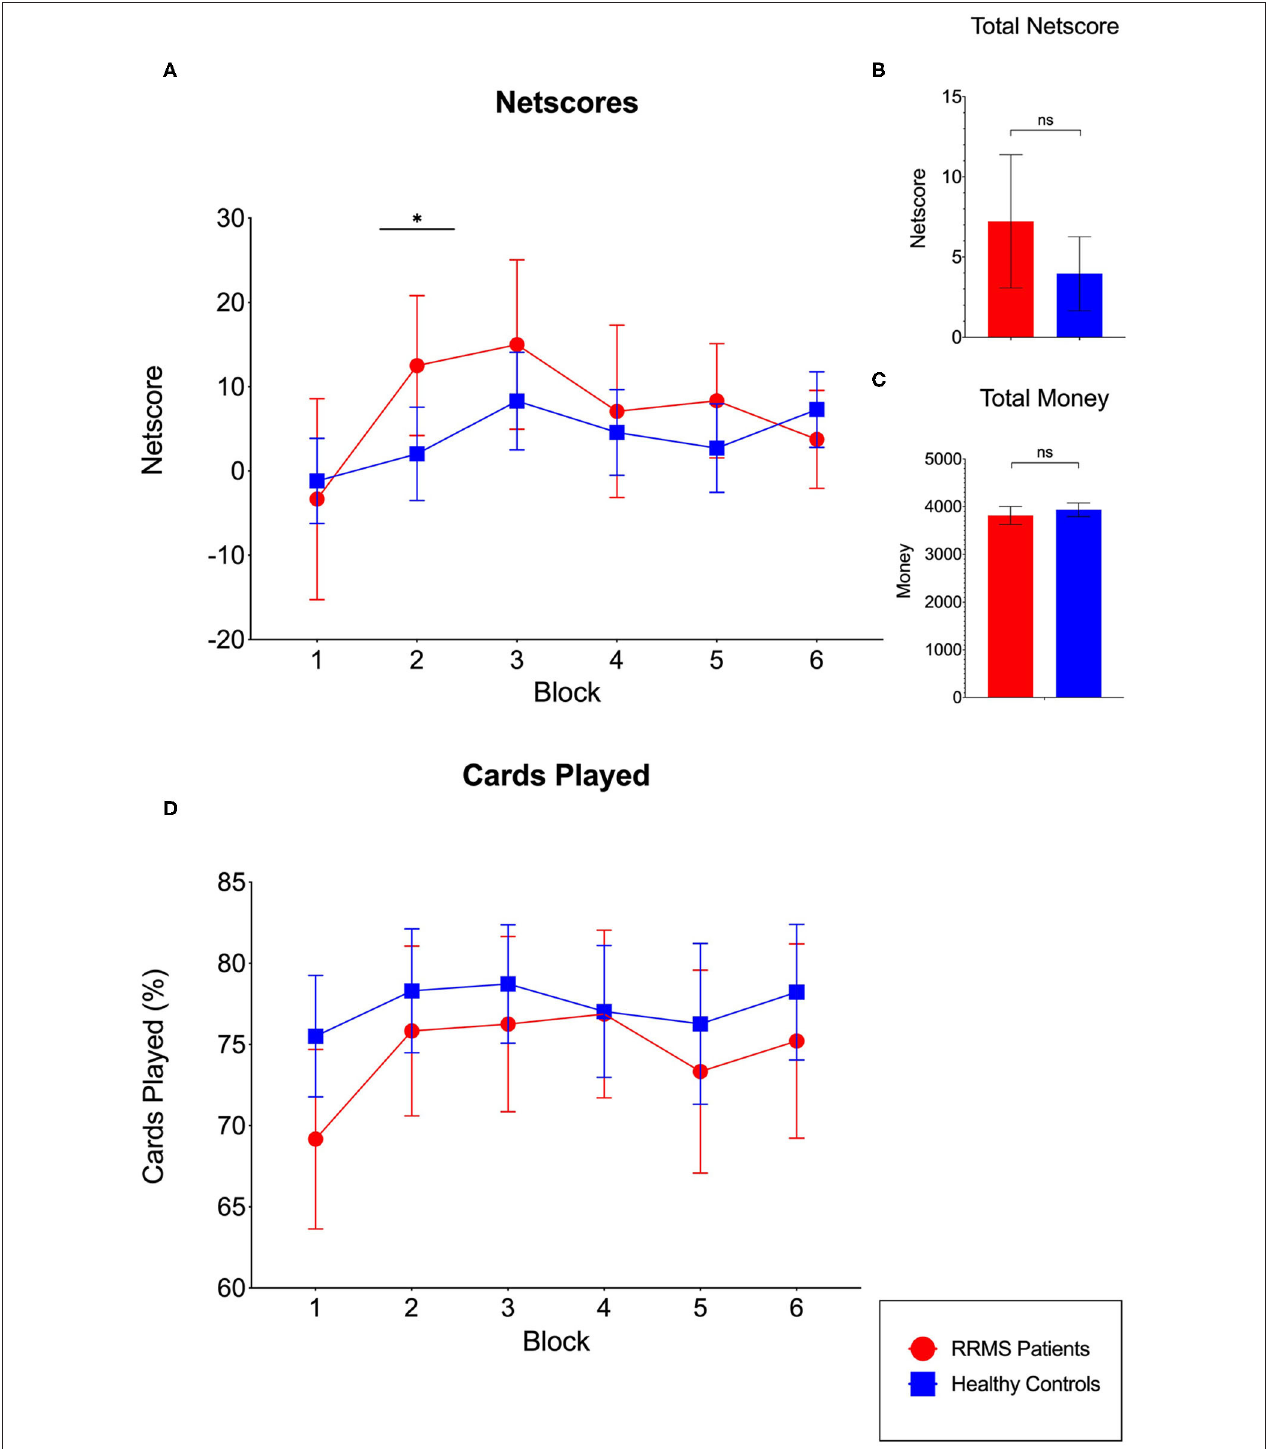
FIGURE 1 | Performance of the relapsing–remitting multiple sclerosis (RRMS) patient group and the healthy control (HC) group in the modified Iowa gambling task (IGT). (A) Evolution of the netscore (difference between the percentage of advantageous and disadvantageous decisions, with the latter being subtracted from the former) during the six blocks of the task. Only block 2 revealed significant differences, indicating better performance of the RRMS patients. (B) The total netscore revealed no significant differences between groups. (C) The total amount of money at the end of the task was comparable between the RRMS patients and HCs. (D) Evolution of the percentage of cards played during the six blocks of the task. No differences between the RRMS patients and HCs in any of the six blocks emerged.